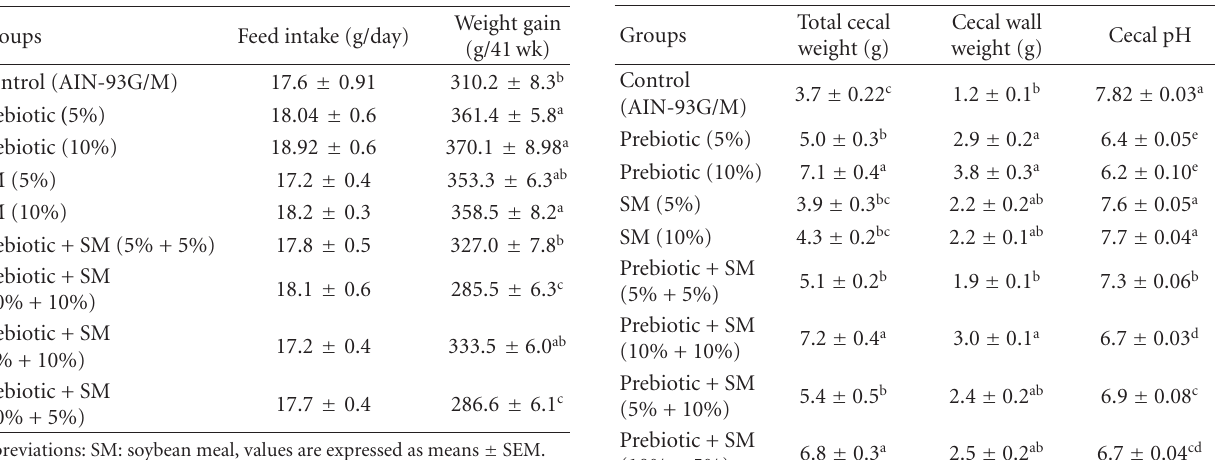
Table 3: E ff ect of prebiotics and soybean meal on cecal weight and cecal pH.